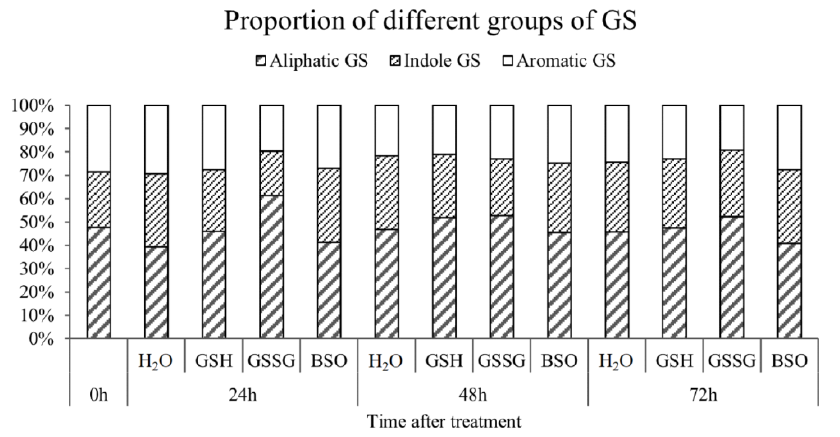
Figure 11. Effect of exogenous GSH/GSSG on the content of total GS and the proportion of different groups of GS in leaves of pakchoi.